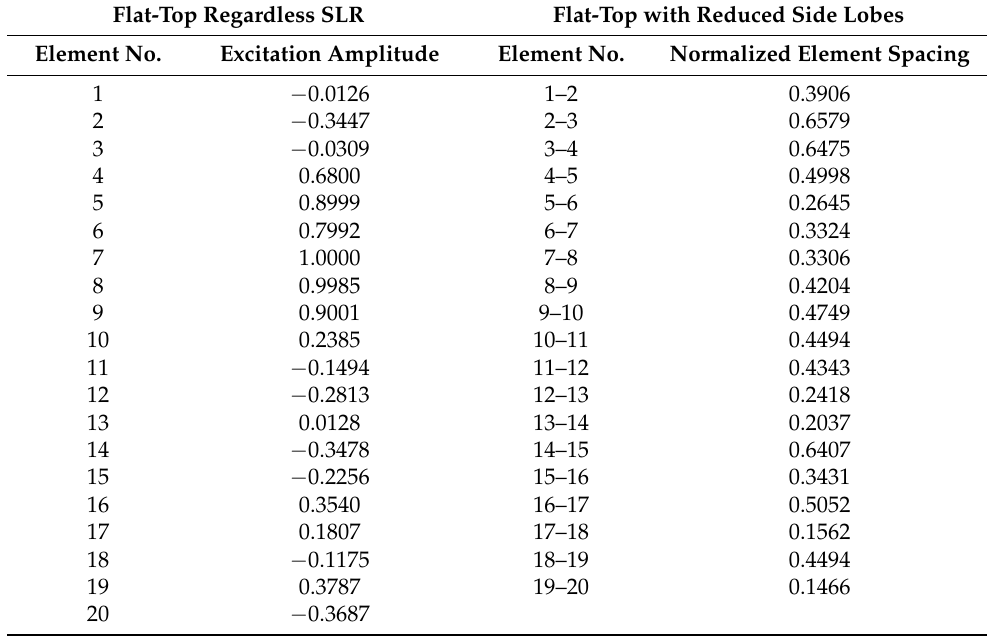
Table 6. The best normalized value of the amplitude of the excitation current and element spacing with respect to λ using FKE for flat-top pattern. Flat-Top Regardless